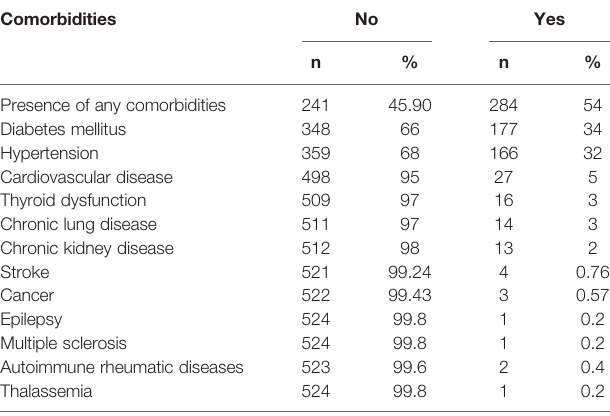
Presence of any comorbidities